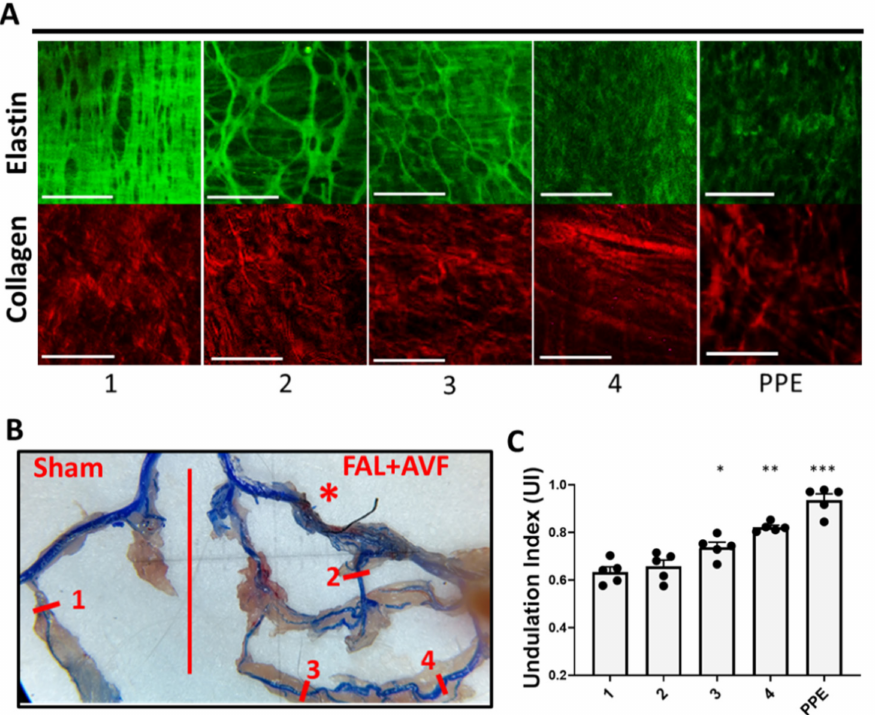
Figure 4. Elastic fiber continuity is stressed with greater relative diameter enlargement. ( A ) Images of the IEL and adventitial collagen isolated from various arterial segments (#1–4) at 4 weeks, compared to elastase-treated common femoral arteries (PPE). Images acquired with Olympus FV1000MPE utilizing 830 nm laser. Sham PFA (1), from the FAL + AVF limb: PFA (2), and sections from MscAs (3,4). ( B ) Microfil infused to the arterial tree to aid in dissection of small muscular collateral vessels. Numbered line segments corresponding to imaging locations of ( A , C ). Red * indicates location of FAL + AVF. ( C ) Average adventitial collagen undulation index was calculated for each vessel (comparisons made by one-way ANOVA with Tukey’s multiple comparisons). N = 5 vessels imaged and analyzed per location shown in B. * 3 compared with 1, p < 0.05; ** 4 compared with 1 and 2, p < 0.001; and *** PPE compared with 1–4, p < 0.05. Bar = 50 µ